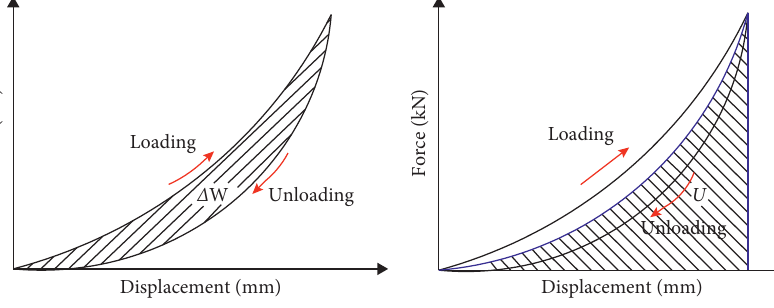
Figure 6: Sketch of the hysteresis loop.